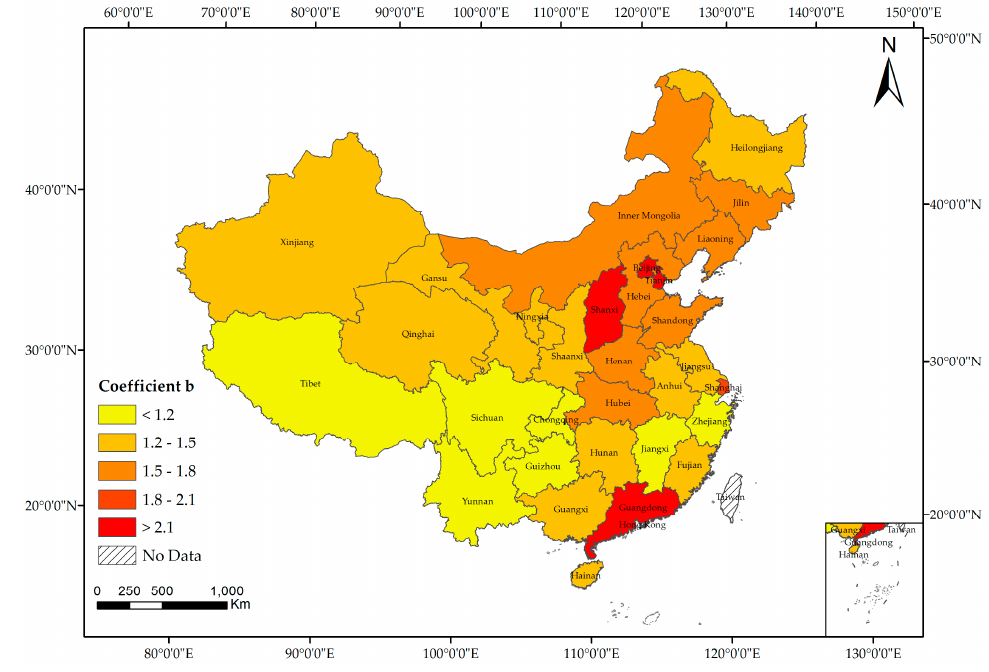
Figure 7. Spatial distribution of gaps in the growth rates between TNL and GDP at the provincial level.